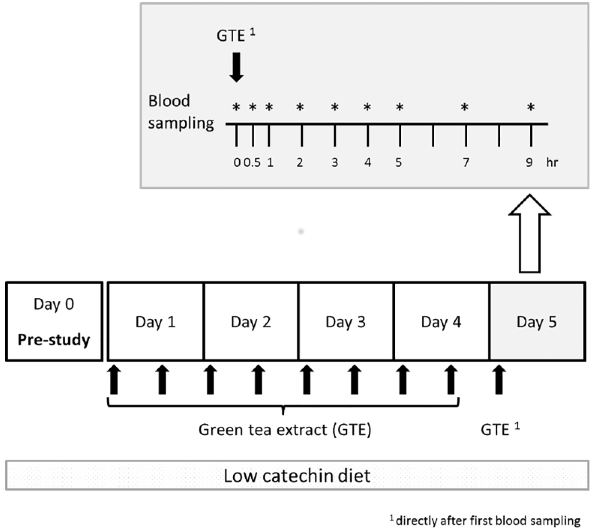
Fig 2. Schematic representation of the study design and blood sampling. The experiment includes one pre-study day and 5 days treatment with standardized green tea extract (GTE). Blood sampling for nutrikinetics takes place